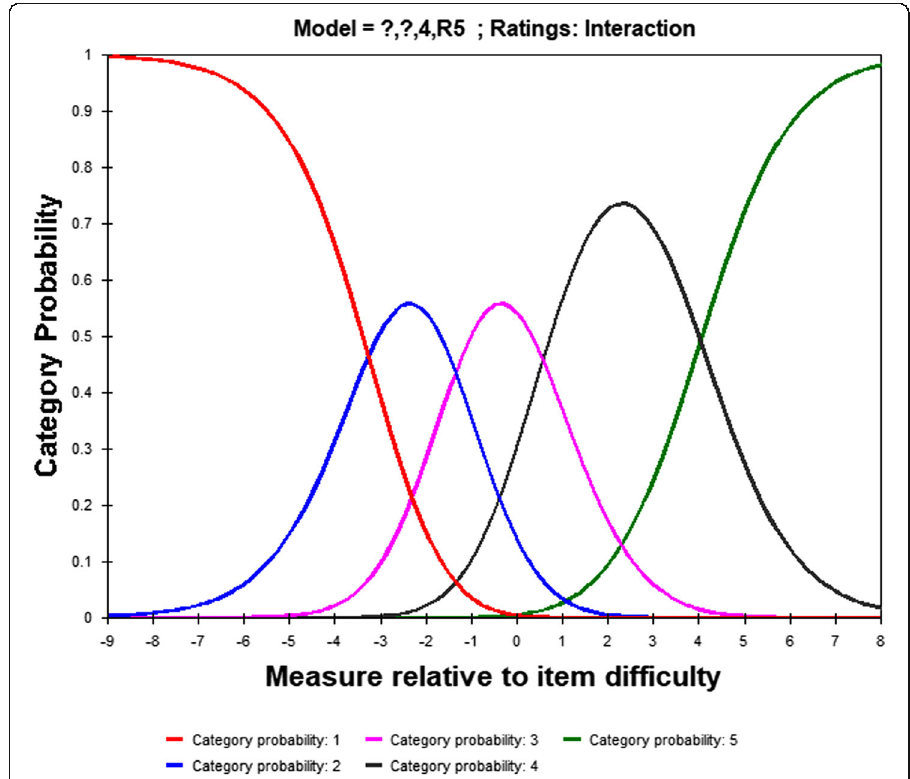
Fig. 4 Category probability curves for the 5-point interaction scale